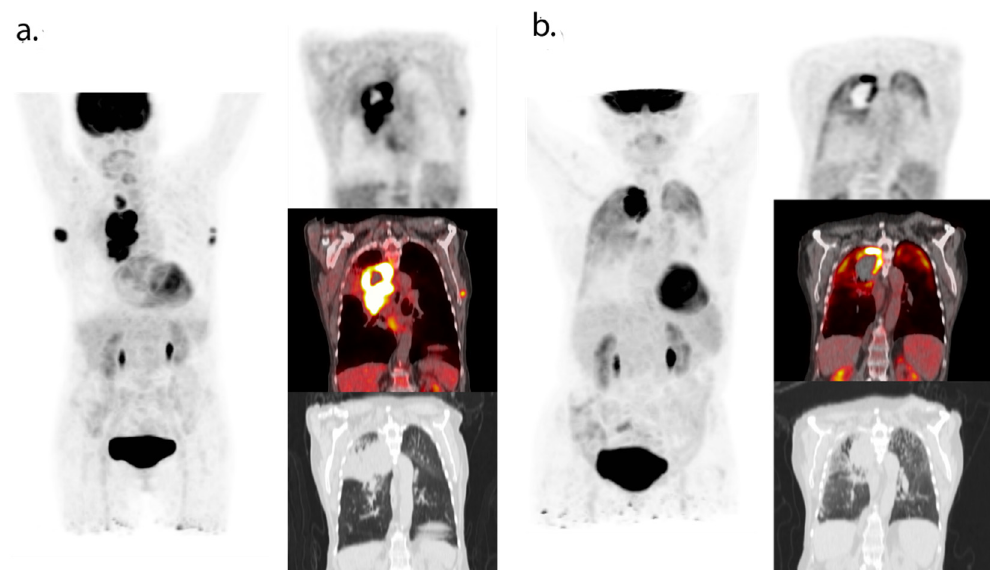
Figure 3. 18 F-FDG-PET/CT (maximum intensity projection and coronal PET, fused PET/CT and CT images) at baseline ( a ) and during follow-up of immunotherapy ( b ). These images were obtained in our clinical institution as part of routine clinical follow-up. The patient provided verbal consent for the use of these anonymized imaging data. At baseline, 18 F-FDG-PET/CT showed an NSCLC tumor in the right lung and lymph node metastases in the left and right axilla. The patient was treated with pembrolizumab monotherapy and obtained a partial response. 18 F-FDG-PET/CT six months after initiation of therapy showed oligoprogression in the right upper lobe. No new disease activity was observed in the lymph nodes. The patient received radiotherapy on the tumor located in the right lung and remained in remission.